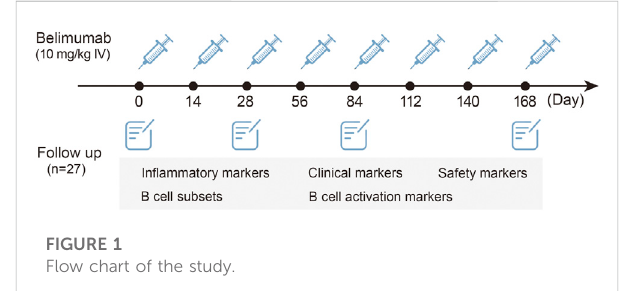
FIGURE 1 Flow chart of the